Question: Which kind of chart has been used to present this data?
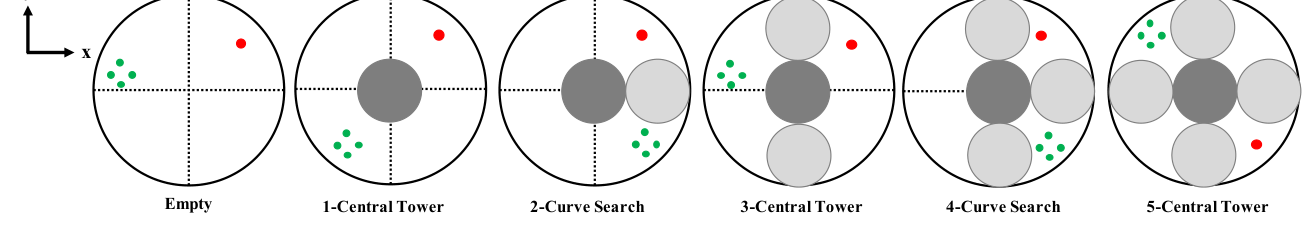
Answer: line